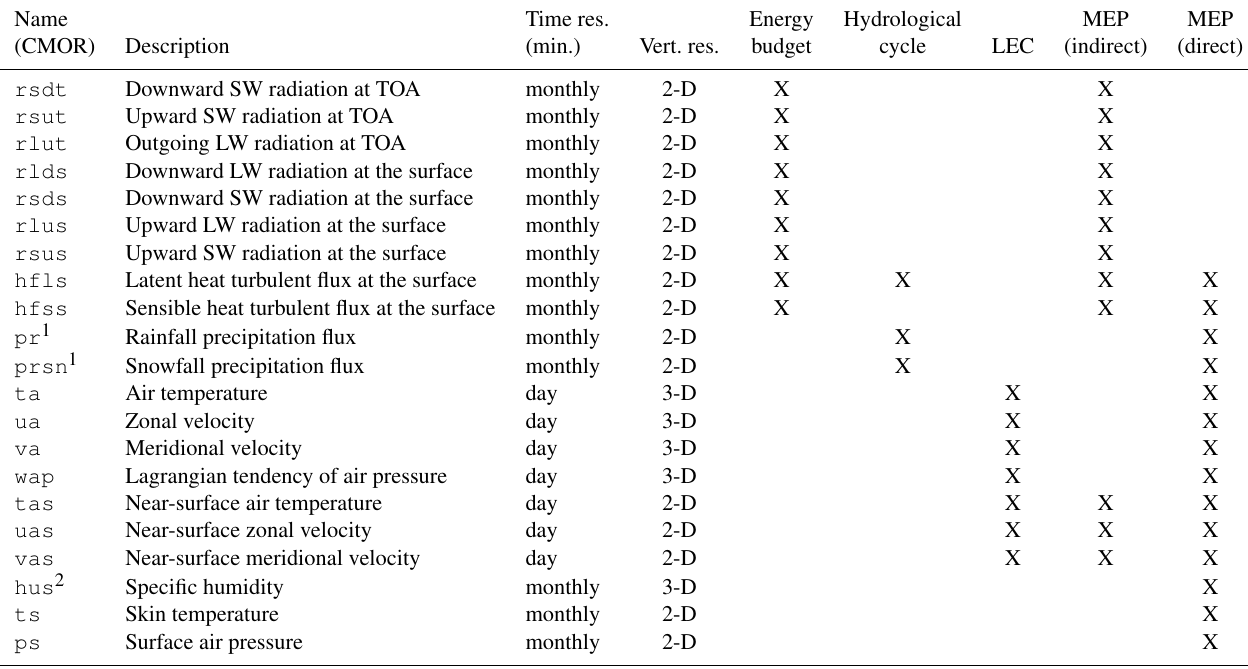
Table 1. Variables used in the modules of the diagnostic tool. Name Time